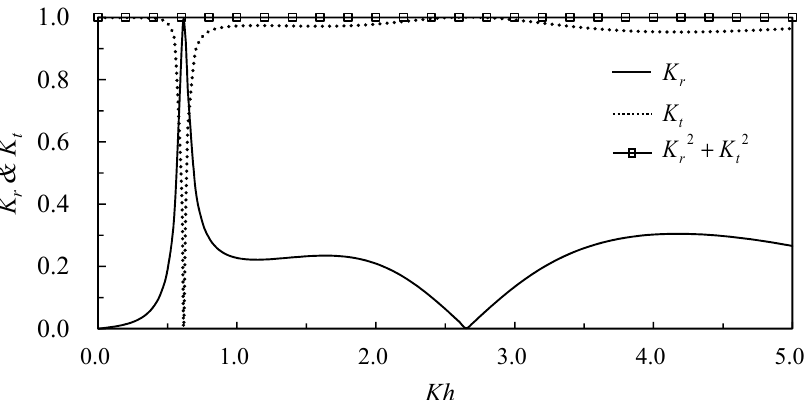
Figure 3. Reflection coefficient; transmission coefficient; and total energy versus relative water depth, Kh ( C D = 0.0, d 1 / h = 0.2, (cid:96) / h = 0.5, a / h = 0.3, and C M = 2.0).